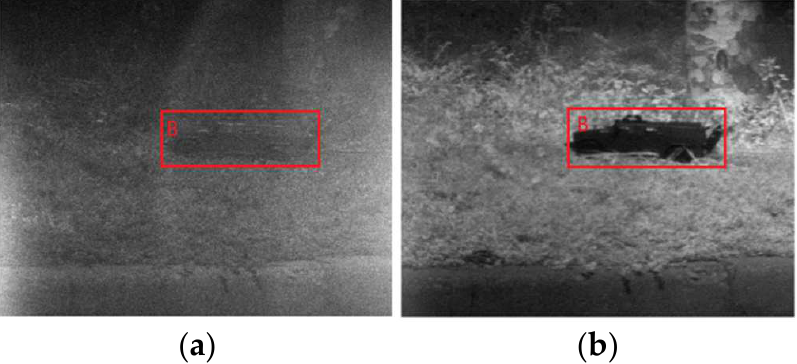
Figure 10. Grayscale images of experimental scenes under different wavelength channels in the first group of experiments. ( a ) Grayscale image of the experimental scene under a 609 nm channel. ( b ) Grayscale image of the experimental scene under a 769 nm channel.